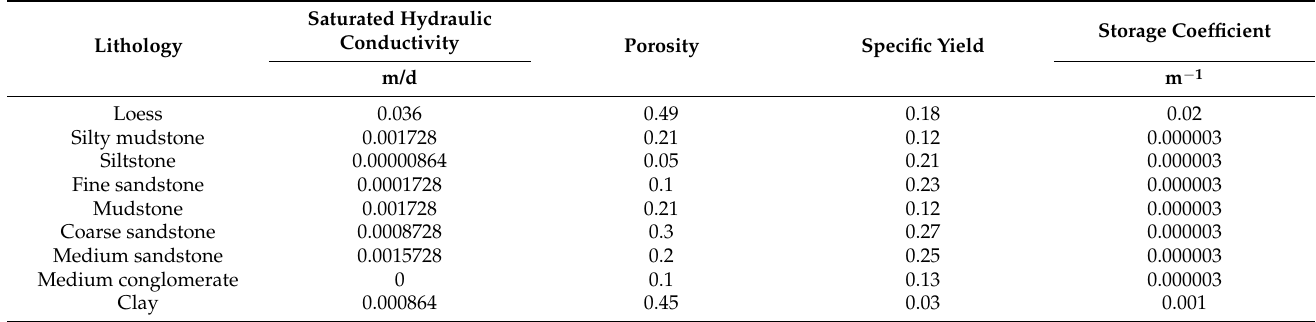
Table 1. Hydrogeological parameters of the main strata lithology in the mining area.